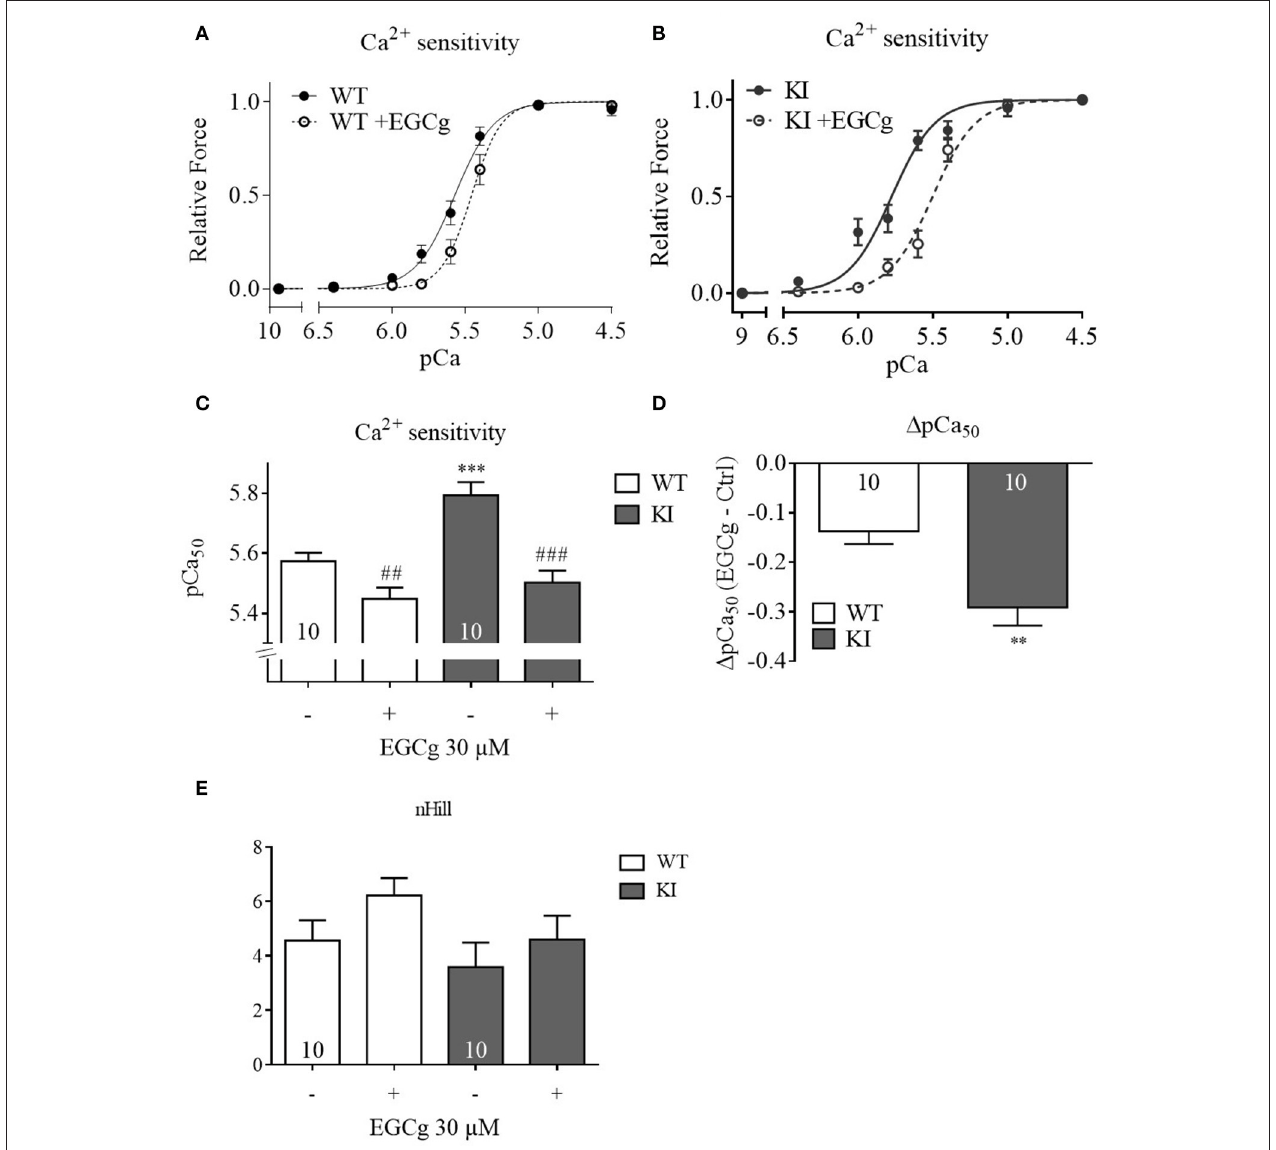
FIGURE 4 | Force-Ca 2 + relationship of permeabilized cardiac muscle strips of WT and KI mice before and after treatment with 30 µ M EGCg. Force-Ca 2 + concentration in (A) WT strips, (B) KI strips. ( C) The pCa 50 represents the measure of myofilament Ca 2 + -sensitivity. (D) Delta of pCa 50 before and after EGCg. (E) nHill coefficient ± EGCg. ** P < 0.01 and *** P < 0.001 vs. WT in the same condition, unpaired Student‘s t -test; ## P < 0.001 and ### P < 0.001 vs. baseline, paired Student‘s t -test, concentration response curves were fitted to the data points and curve comparison was done by using extra sum-of-squares F -test; n = 10; N = 6